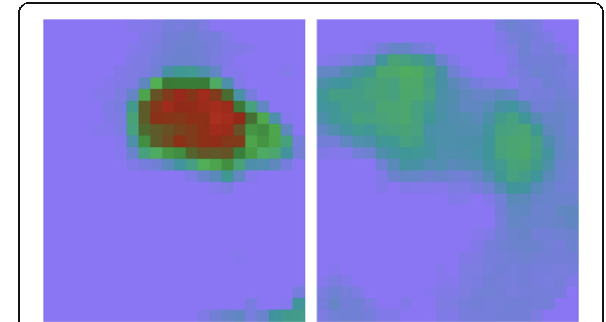
Fig. 15 Measured contact pressure in the knee joint under 1000 N by Tekscan sensor